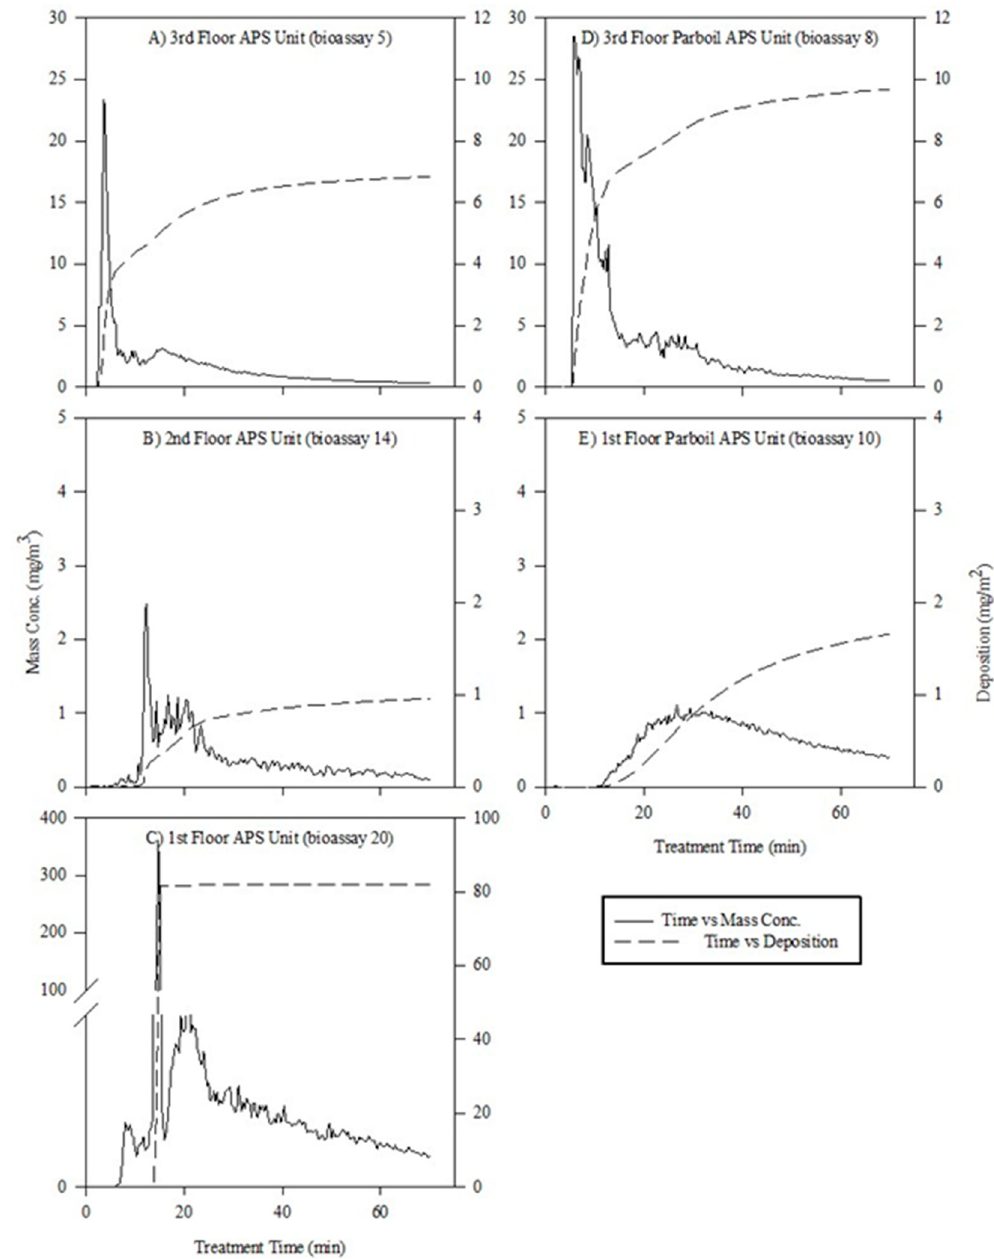
Figure 5. A comparison of the mass concentration (mg/m 3 , left y-axis, solid line) and estimated particle deposition (mg/m 2 , right y-axis, dashed line) during the aerosol treatment time (x-axis). Data is from ( A ) Aerodynamic Particle Sizer Spectrometers (APS) unit located on the third floor of the milling facility; ( B ) APS unit located on the second floor of the milling facility; ( C ) APS unit located on first floor of the milling facility; ( D ) APS unit located on the third floor of the parboil facility; and ( E ) APS unit located on the first floor of the parboil